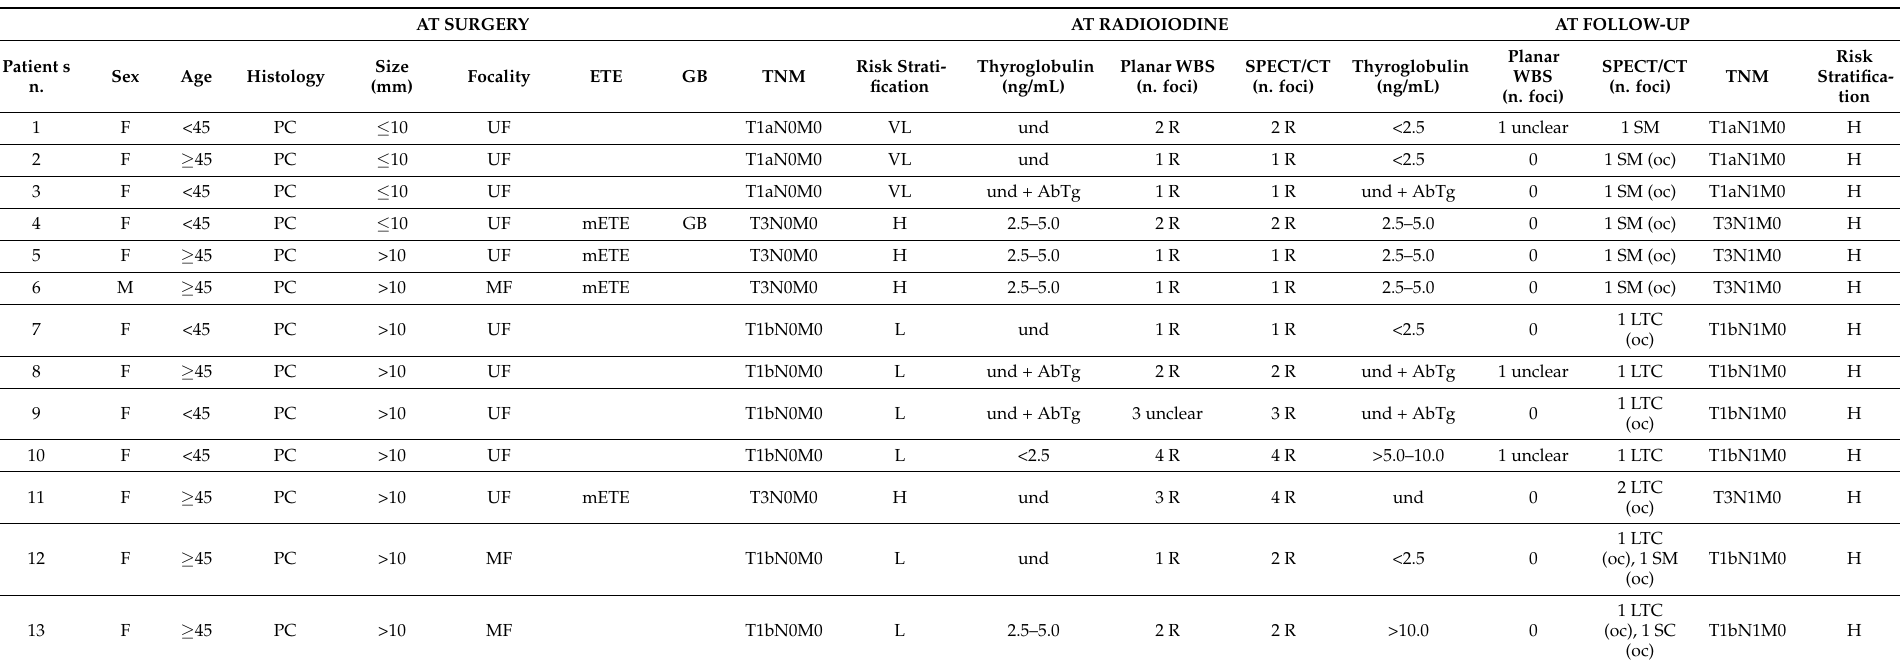
Table 4. 131 I-SPECT/CT and WBS and thyroglobulin levels assay in 13 DTC patients with absence of metastases both at surgery and at radioiodine ablation imaging, undergone neck lymph node metastases during follow-up. AT SURGERY AT RADIOIODINE AT FOLLOW-UP Patient s